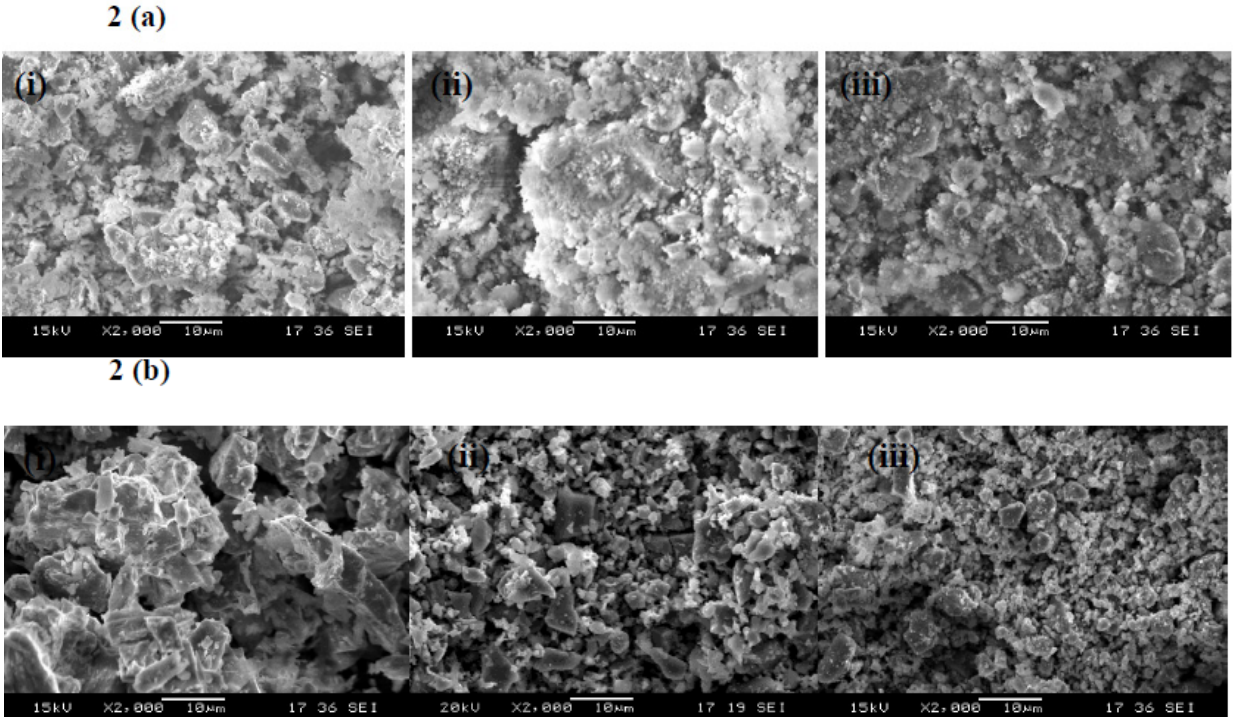
Figure 2. SEM image of ( a ) alumina supported Nickel ball milled for ( i ) 1h. ( ii ) 2 h. ( iii ) 4 h and ( b ) Magnetite ball milled for ( i ) Without ( ii ) 1 h ( iii ) 2 h ball milling at 2000×